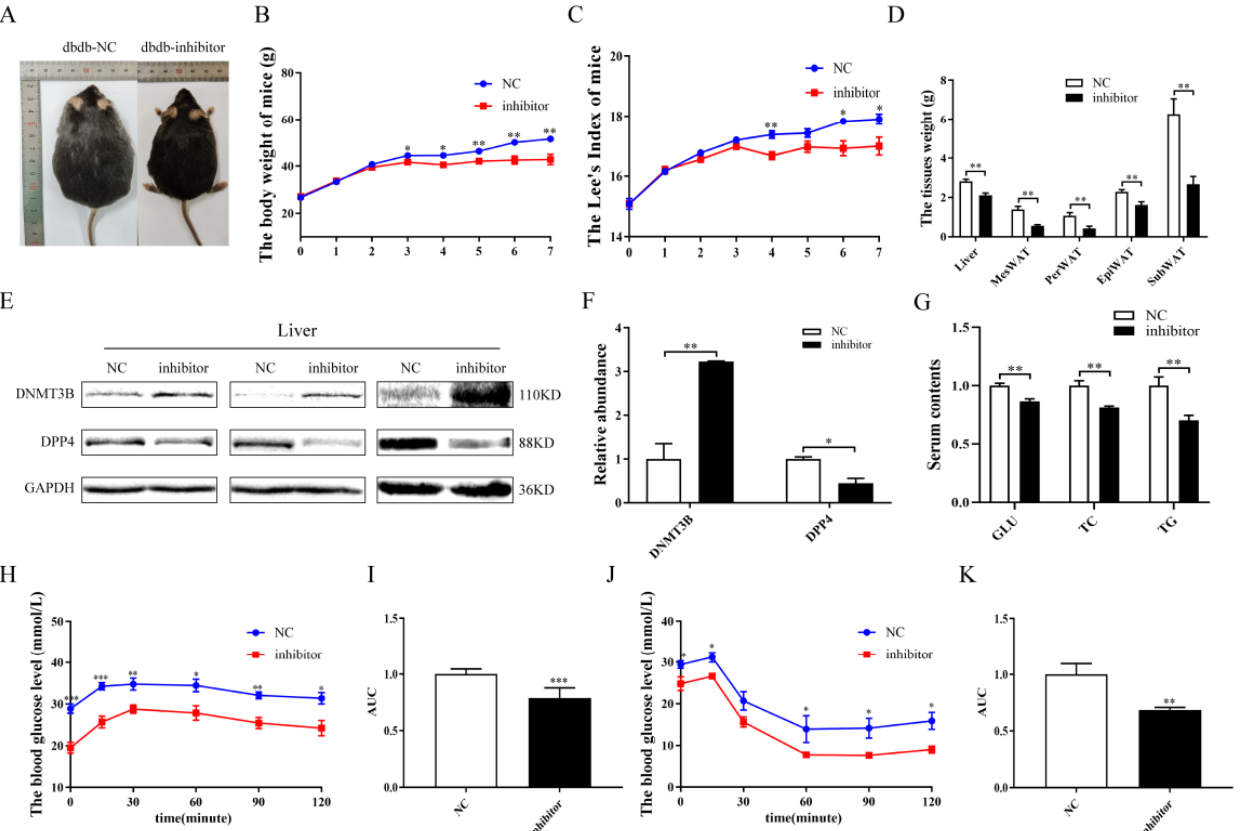
Figure 8. Effect of the miR-548ag inhibitor on db/db mice. ( A ) The gross morphology of the db/db + NC and db/db + inhibitor mice. ( B ) Comparison of the body weights prior to and after the intraperitoneal injection of the inhibitor ( n = 6). ( C ) Lee’s index ( n = 6). ( D ) The weight of the liver tissue, MesWAT, PerWAT, EpiWAT, and SubWAT ( n = 6). ( E , F ) The protein expressions of DNMT3B and DPP4 in the liver. ( G ) The levels of blood glucose, TC, and TG ( n = 6). ( H ) IPGTT assay results ( n = 6). ( I ) The quantification of glucose tolerance. ( J ) ITT assay results ( n = 6). ( K ) The quantification of insulin sensitivity. (The p -values obtained in the t -test and non-parametric rank sum test are indicated. The data are presented as mean ± SEM. * p < 0.05, ** p < 0.01, and *** p < 0.001 indicate a significant difference.)